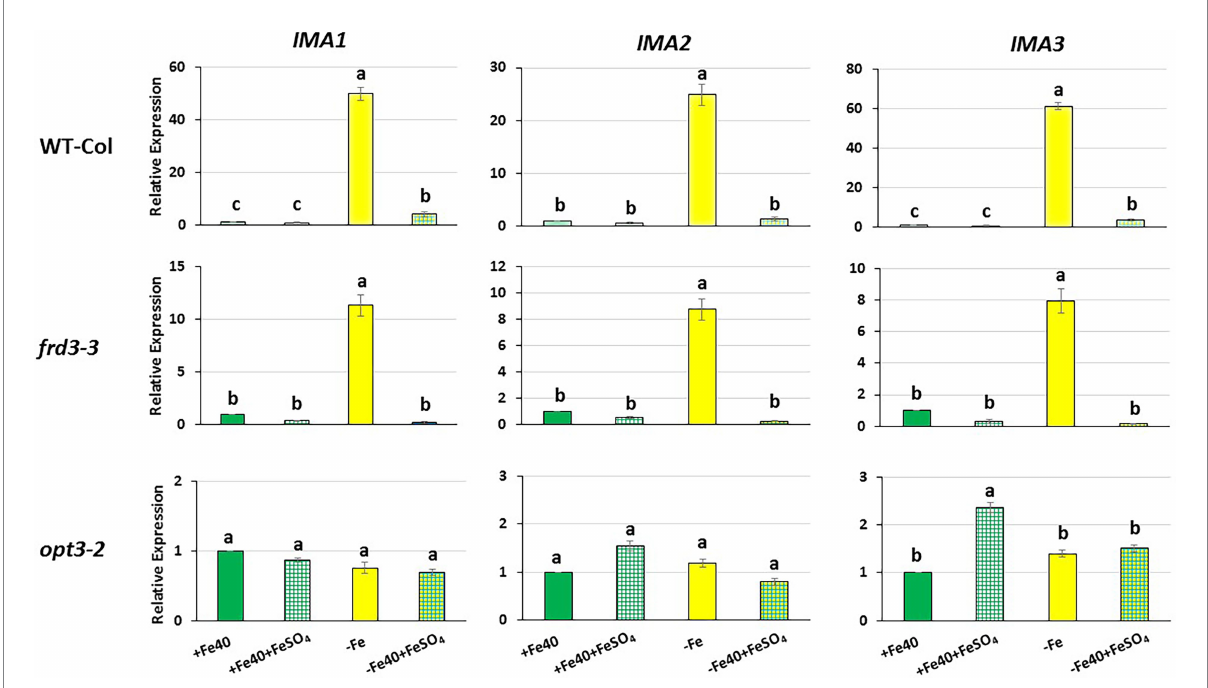
FIGURE 4 Effect of the foliar application of Fe on IMA1 , IMA2 and IMA3 expression in roots of Arabidopsis WT Columbia and its LODIS defective mutants frd3-3 and opt3-2 grown under Fe-sufficient and Fe-deficient conditions. Plants were grown in complete nutrient solution. When appropriate, some of them were transferred to complete nutrient solution with 40 μ M Fe-EDDHA (+Fe40) or without Fe (–Fe). 24 h later, half of the plants of each treatment (+Fe 40 and –Fe) were sprayed with FeSO 4 (0.05% w/v) on their leaves (+Fe40 + FeSO 4 ; –Fe + FeSO 4 ). 24 h after the foliar treatments, roots were collected and IMA1 , IMA2 and IMA3 expression was determined by qRT-PCR. Relative expression was calculated in relation to the +Fe40 treatment. Data represent the mean of 3 independent biological replicates ± S.E. Bars with different letters indicate significant differences ( p < 0.05) using one-way analysis of variance (ANOVA) followed by a Tukey’s